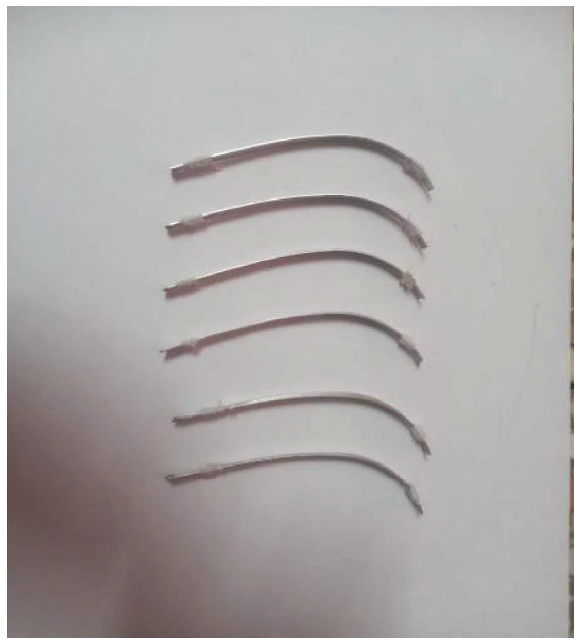
Figure 1: Te sample